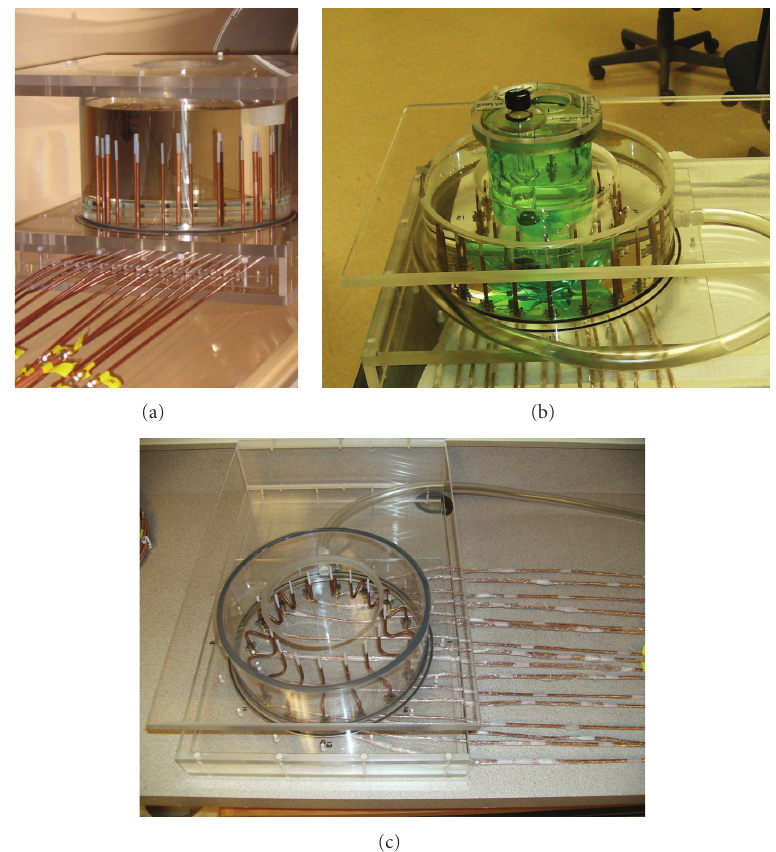
Figure 5: Photographs of the three imaging tanks and antennas used in experiments: (a) taller tank with straight 10 cm feed line lengths, (b) shorter tank with the straight 5cm feed line lengths, and (c) the short tank with the 10 cm feed line lengths in a serpentine